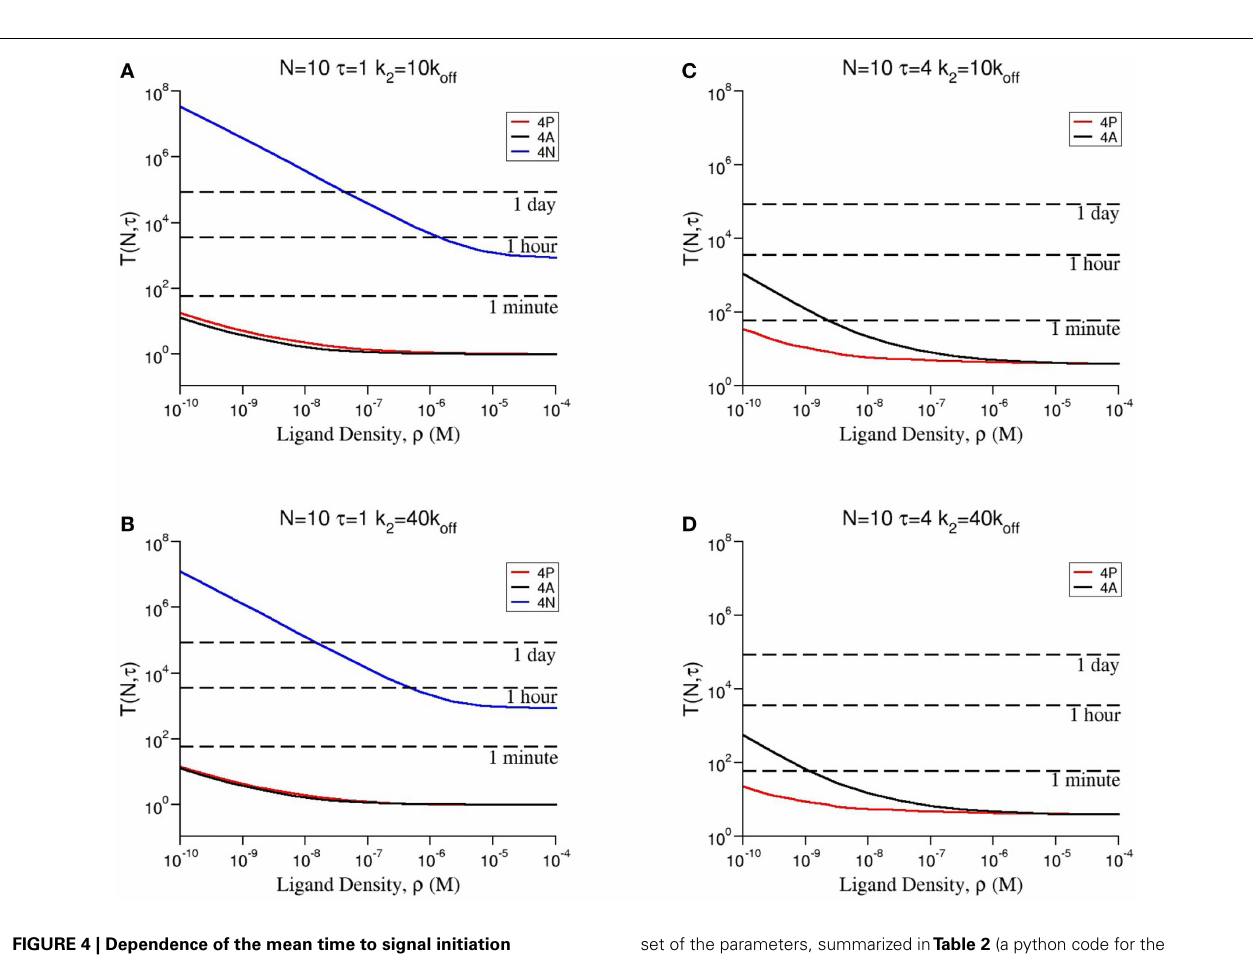
FIGURE 4 | Dependence of the mean time to signal initiation (MTSI), T ( N , τ ) to have N cross-linked ligand–receptor complexes bound for at least a dwell time τ for different model parameters as shown in every panel .The results have been obtained by making use of a Gillespie algorithm, after averaging over 100 realizations for each